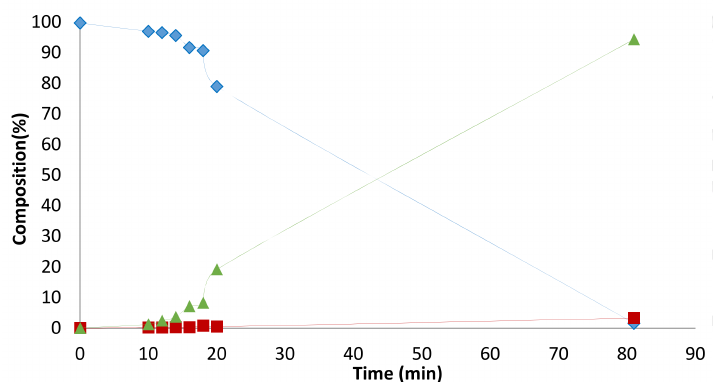
Figure A10. Composition profile at [substrate] 0 /[Rh]= 3000 with 5-hexenenitrile in toluene ( (cid:7) 1 Hex , (cid:4) 1 Hex - int -x , (cid:78) 2 Hex + 3 Hex ). (conditions: 1 Hex = 3.15 mmol, [ 1 Hex ] [biphephos] 0 /[Rh] = 20, P = 20 bar (CO/H 2 = 1:1), solvent (8 mL), T = 120 ◦